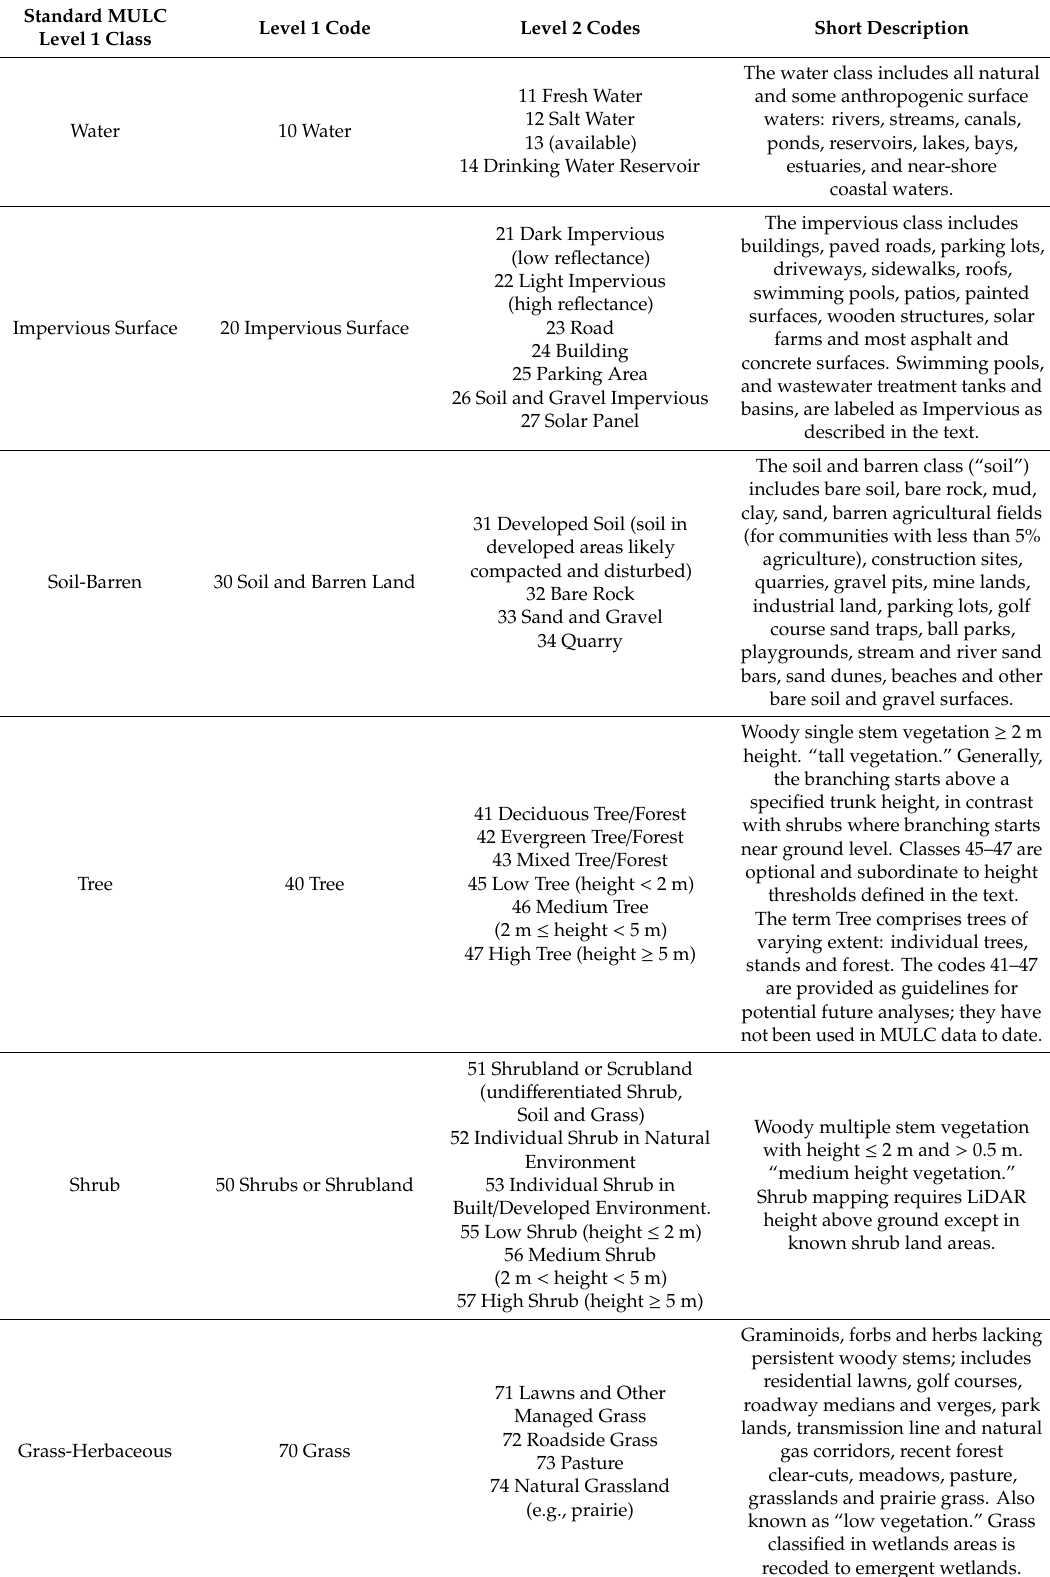
Table 2. MULC Level 1 and 2 class names, codes, and